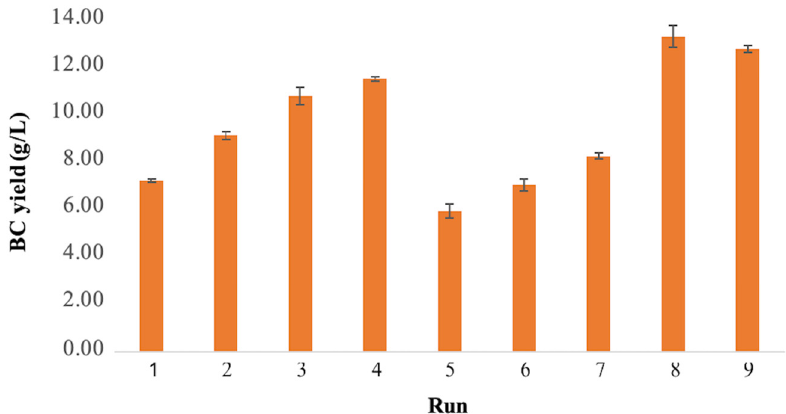
Figure 7: The BC yield ( g/L ) produced by P. kudriavzevii USM - YBP2 with di ff erent carbon concentration, nitrogen concentration, and inoculum size at 30°C, agitated at 200 rpm.